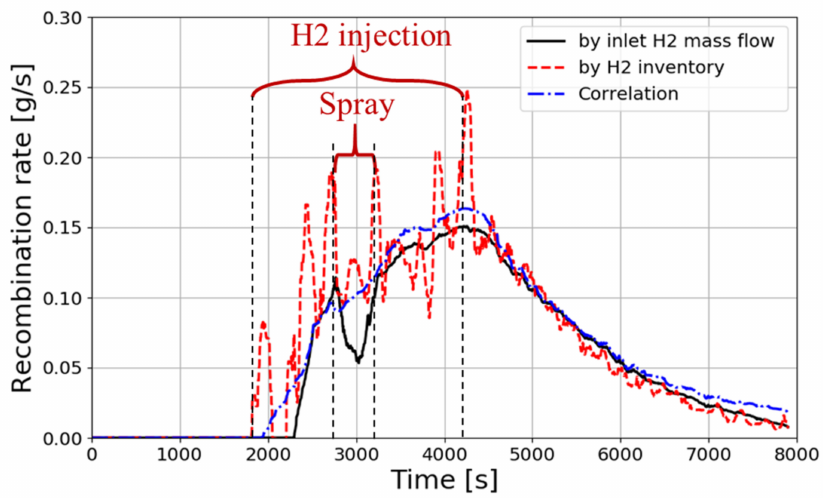
Figure 27. Comparison of the hydrogen recombination rates during the SSP4